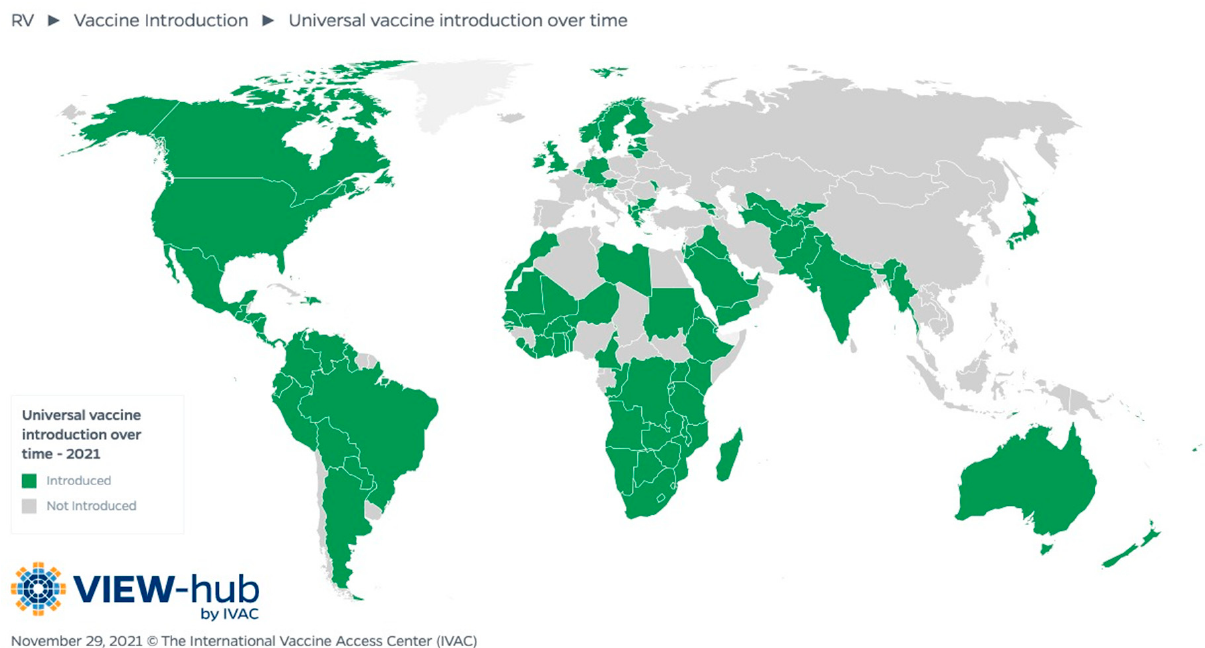
Figure 1. Rotavirus vaccine introduction status.